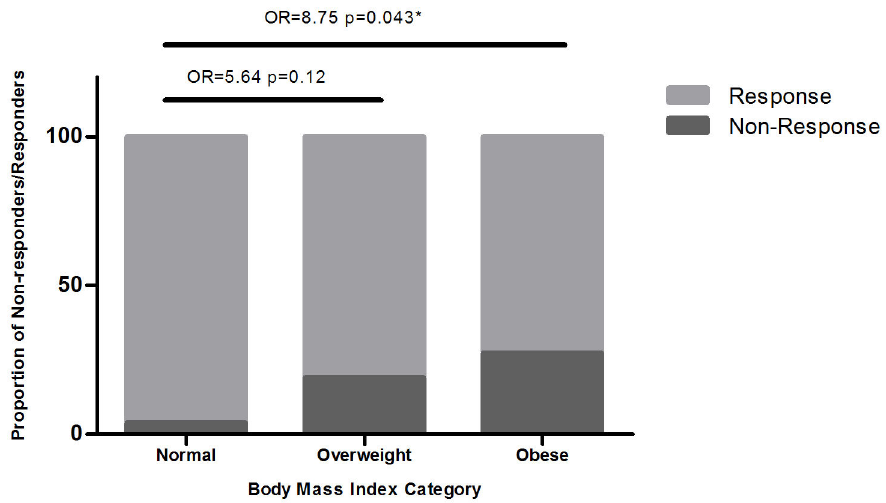
Figure 2. Relative distribution of vaccine non-response by body mass index (BMI) category. Illustrates the proportion of non- responders within each standard BMI category. The underweight category has been excluded as only 4 participants fell into this group.